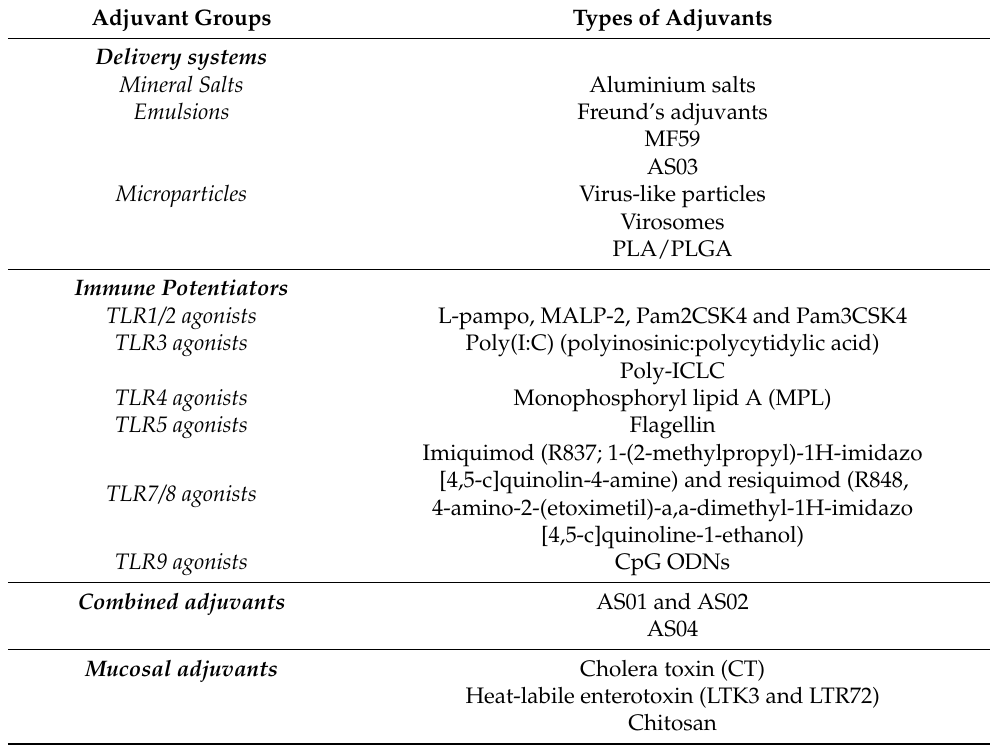
Table 1. Classification of adjuvants according to their main mechanism of